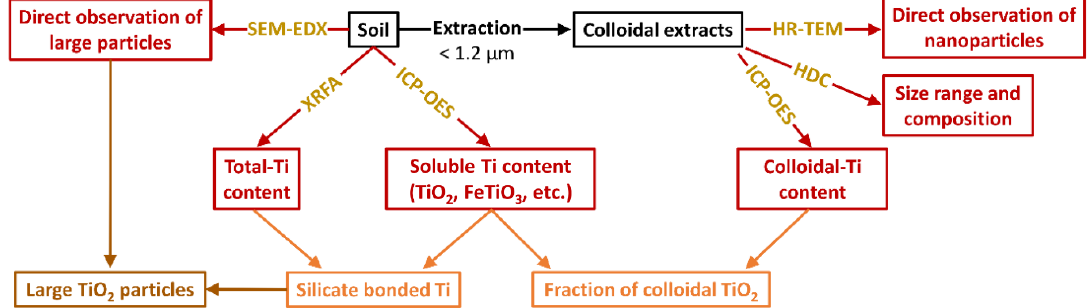
Figure 1. Simplified scheme of the analytical workflow used for characterizing the Ti background present in soils. XRFA: X-ray fluorescence analysis; ICP-OES: induced coupled plasma-optical emission spectrometry; SEM-EDX: scanning electron microscopy-energy dispersive X-ray analysis; HR-TEM: high-resolution transmission electron microscopy; hydrodynamic chromatography.